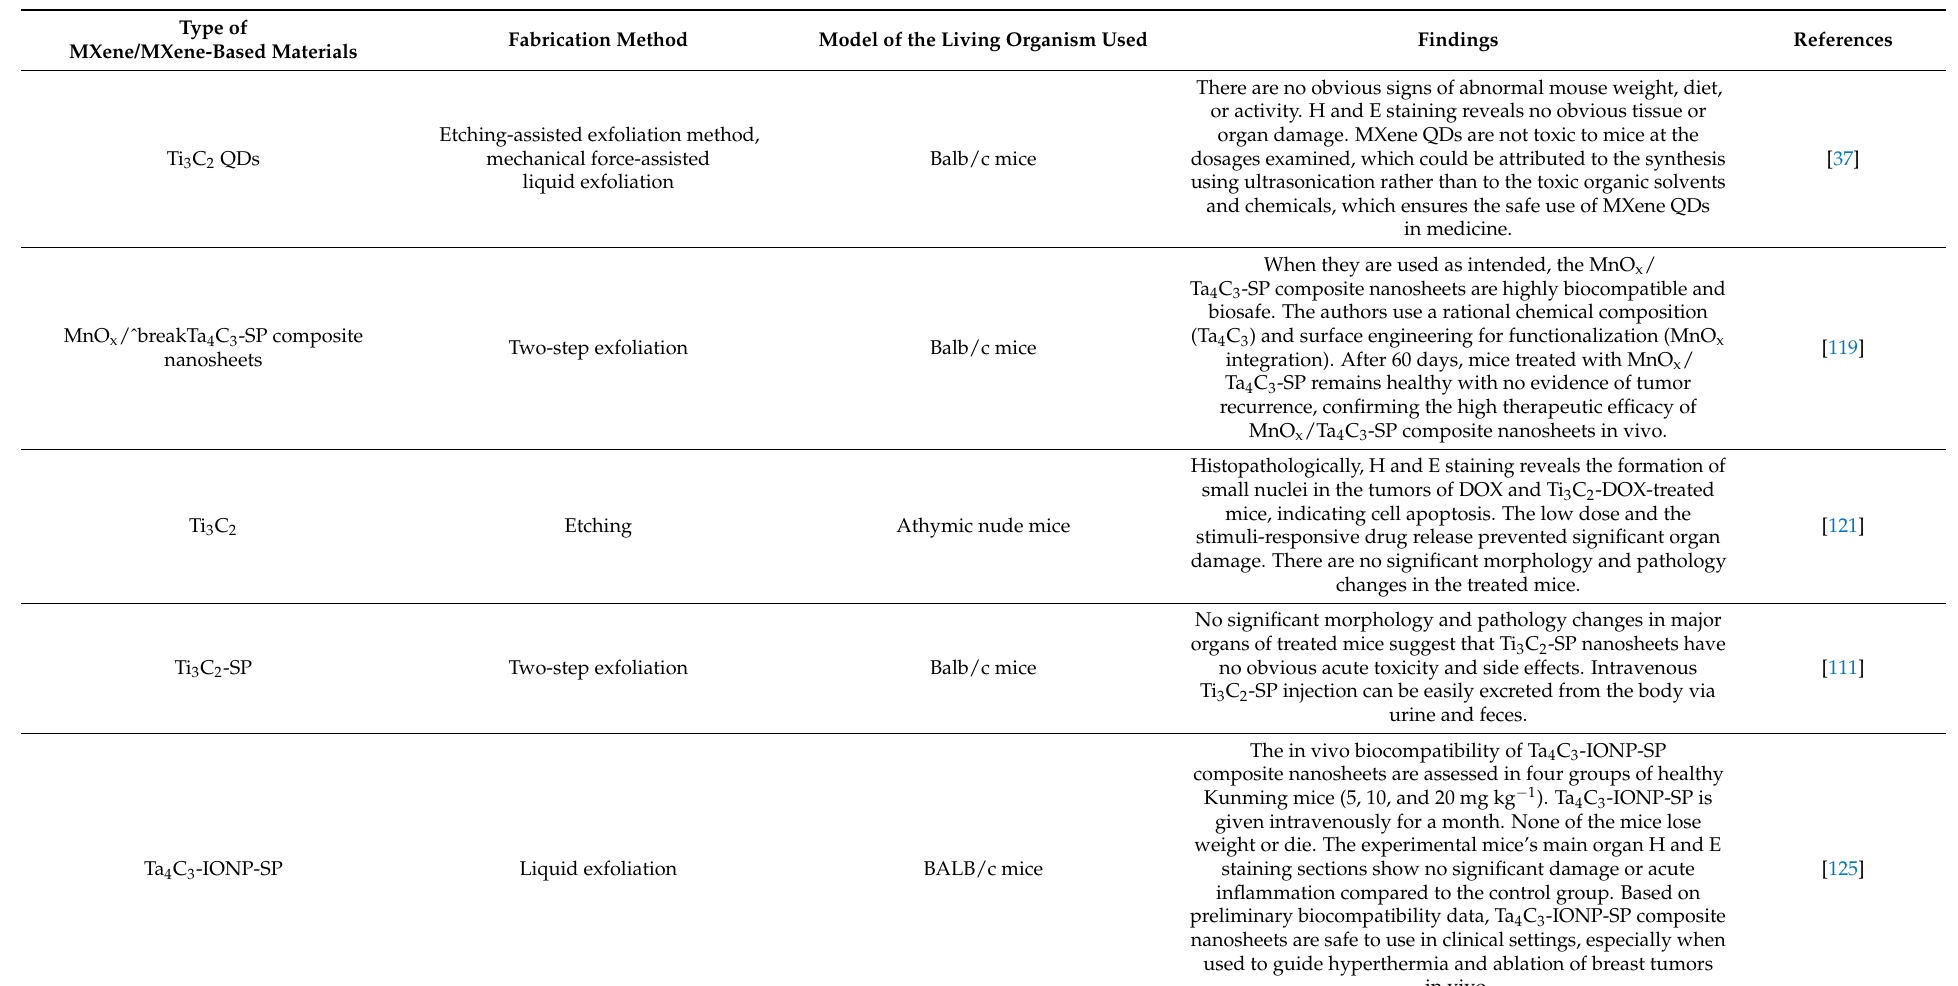
Table 2. In vivo, ecotoxicity, and phytotoxicity of MXenes and MXene-based